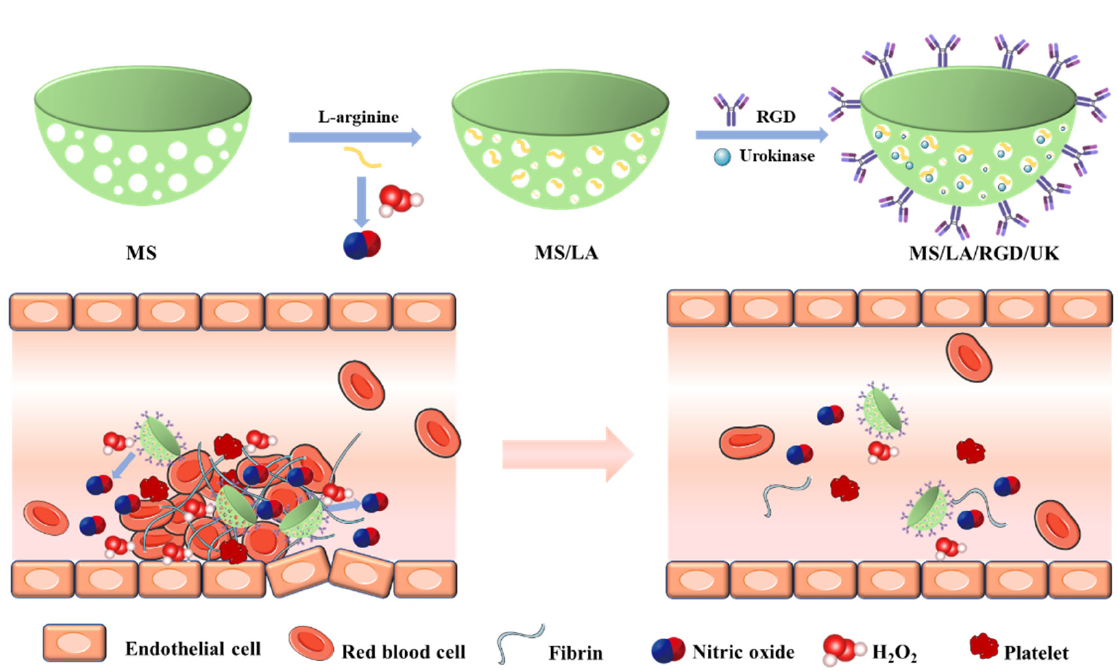
Figure 7. The preparation process of MS/LA/RGD/UK nanomotors and their application in the treatment of thrombosis. Reproduced with permission from [110], Journal of Colloid and Interface Science, 2022.